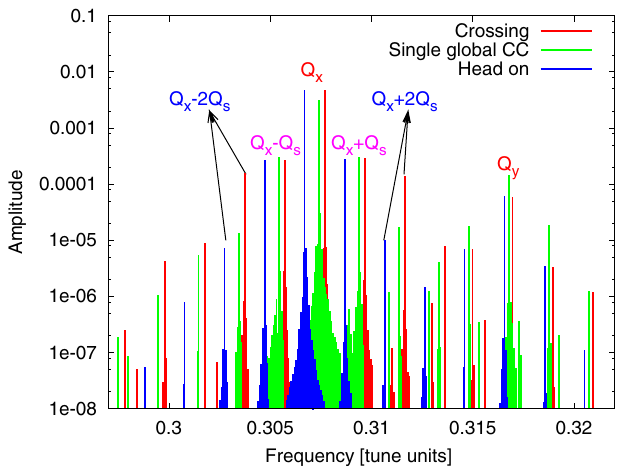
FIG. 30. (Color) Frequency spectrum computed from the turn- by-turn horizontal beam position, with nonlinear magnet errors, for a particle launched with 1 (cid:3) offset in x , y , and z . The second sideband synchrobetatron resonances introduced by the crossing collision are partially suppressed by the single global 800-MHz crab cavity (synchrotron tune Q s ¼ 0 : 001 97 , and chromaticity 2 Q 0 x;y ¼